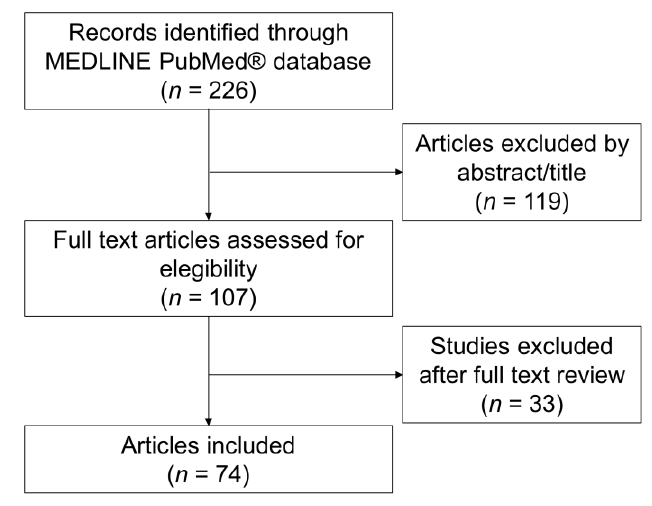
Figure 1. Screening flow chart.